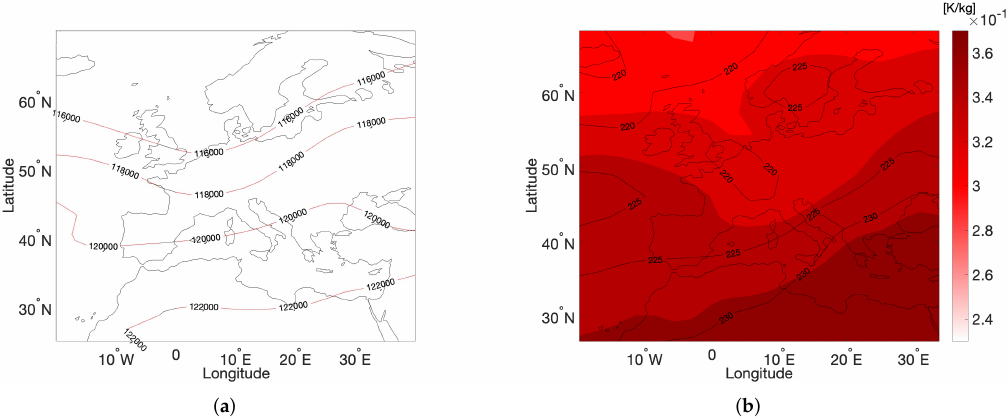
Figure 9. Meteorological parameters and O 3 aCCFs at 250 hPa on 1 August 2016: ( a ) geopotential (isolines, m 2 /s 2 ), ( b ) temperature (isolines, K) and O 3 aCCFs (colour contours, K/kg(NO 2 )). The vertical distribution of the O 3 aCCFs for the selected days can be visualised by plotting its meridional mean in the European area as shown in Figure 10. The pressure levels [315, 180] hPa correspond roughly to the flight corridor within [FL290, FL410]. Most of the climate sensitive regions lie at higher